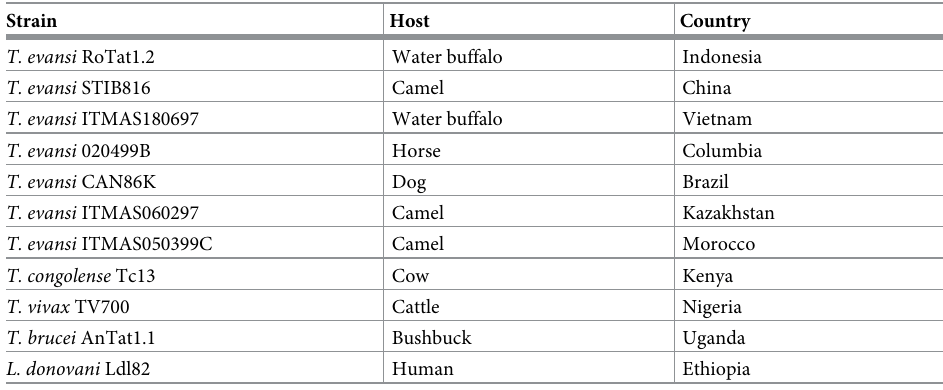
Table 1. Characteristics of trypanosomatid parasites used in this study.